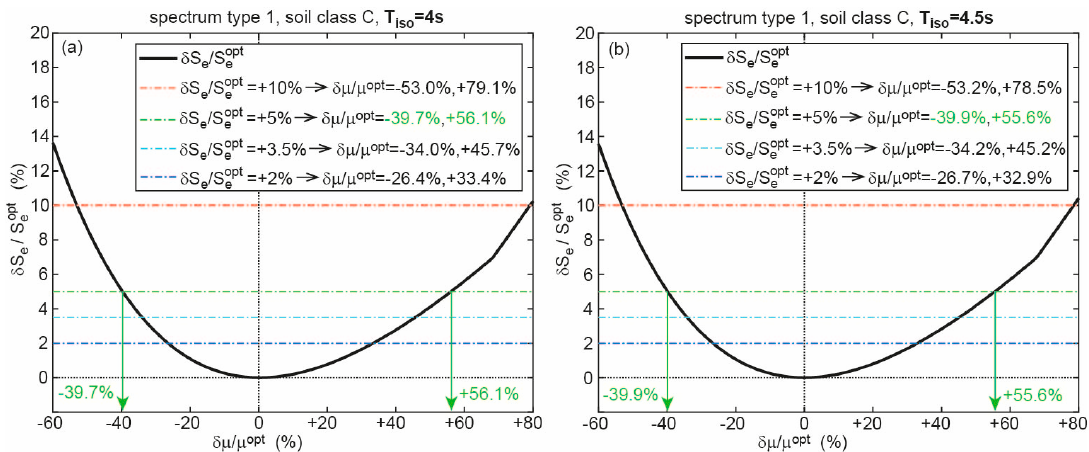
Figure 17. Sensitivity of deviation in friction coefficient from its optimum value on relative increase of structural acceleration for ( a ) T iso = 4 s and ( b ) T iso = 4.5 s and spectrum of type 1 with soil class C. Table 1. Sensitivity results for spectrum of type 1 for relative increase of +5% and +2% in structural acceleration.